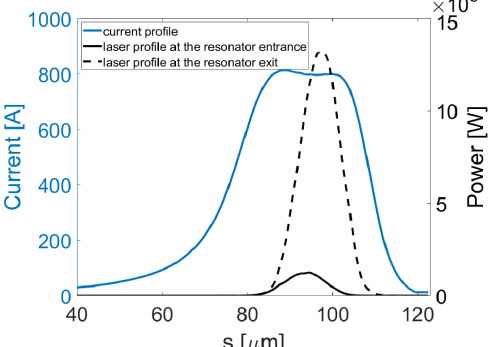
FIG. 2. The beam current distribution (blue line) and seed laser power profile for the single pass (solid black line, at the entrance of the first modulator; dotted black line, at the exit of the first modulator).